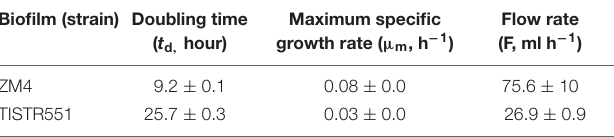
TABLE 2 | Summary of kinetics studies and ideal flow rate (continuous operation) of Z. mobilis ZM4 and TISTR551